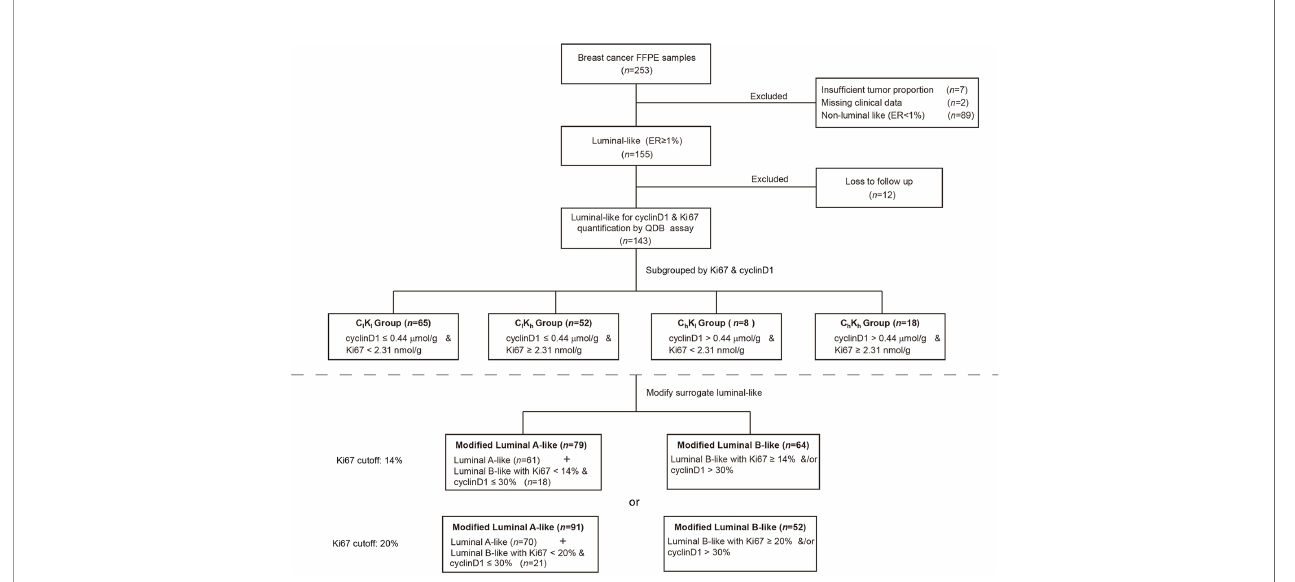
FIGURE 1 | Flow diagram.